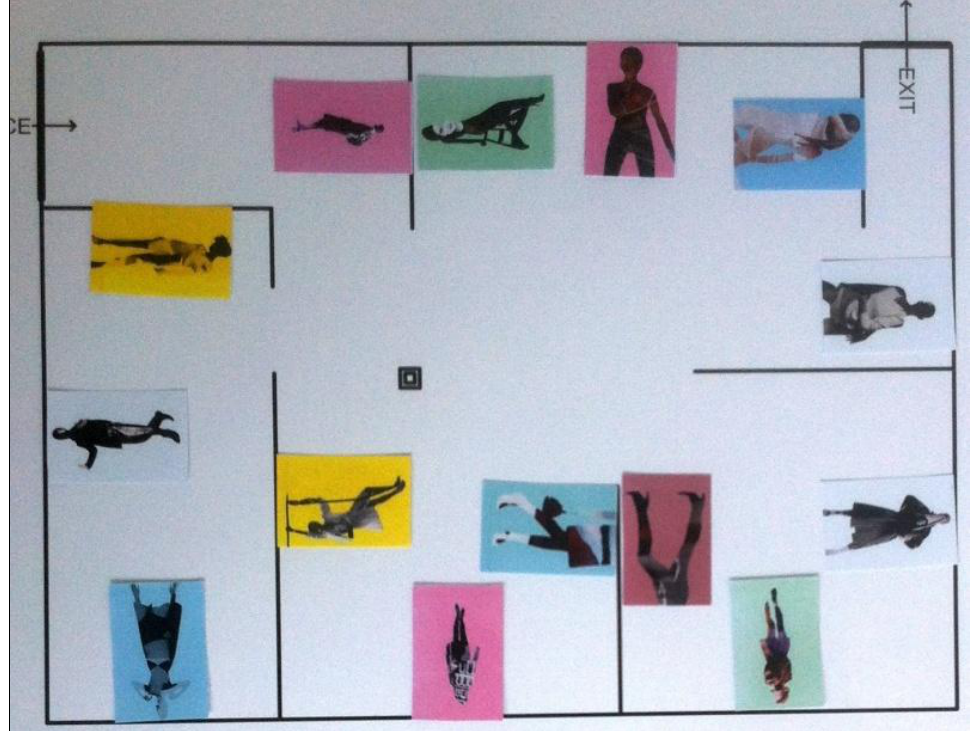
Figure 6. A sample solution of the Miniature